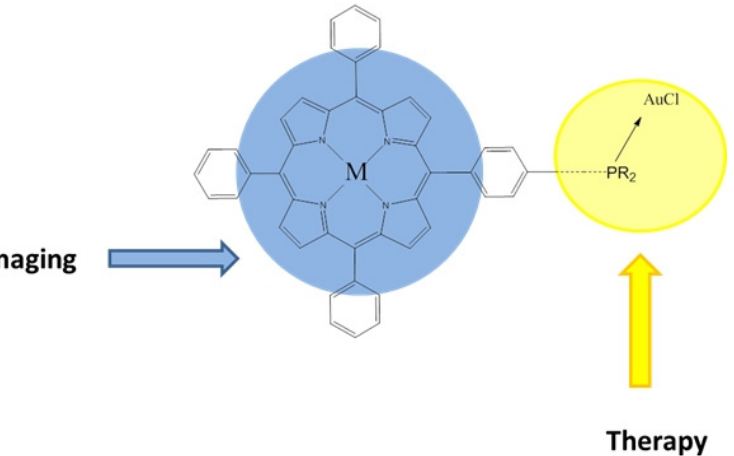
Figure 18. General structure of gold phosphine porphyrin derivatives as new theranostic agents (M = palladium or gold) [109].